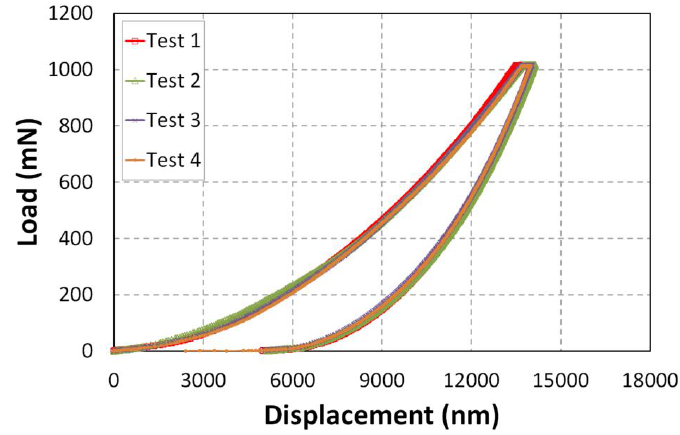
Figure 10. Indentation profile for epoxy matrix, 2.5 wt %NGP.